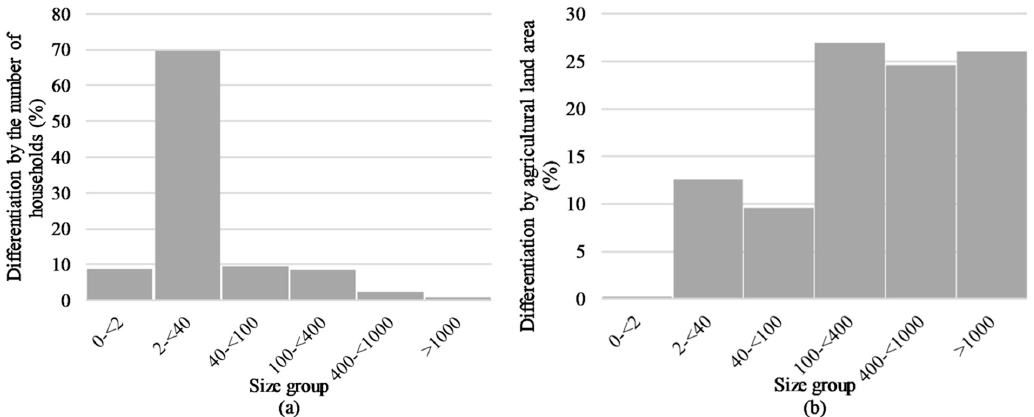
Figure 10. ( a ) Di ff erentiation of size groups by the number of households, ( b ) Di ff erentiation of size groups by agricultural land area in 2016 Figure 10. (a) Differentiation of size groups by the number of households, (b) Differentiation of size groups by agricultural land area in 2016 (ARIB).